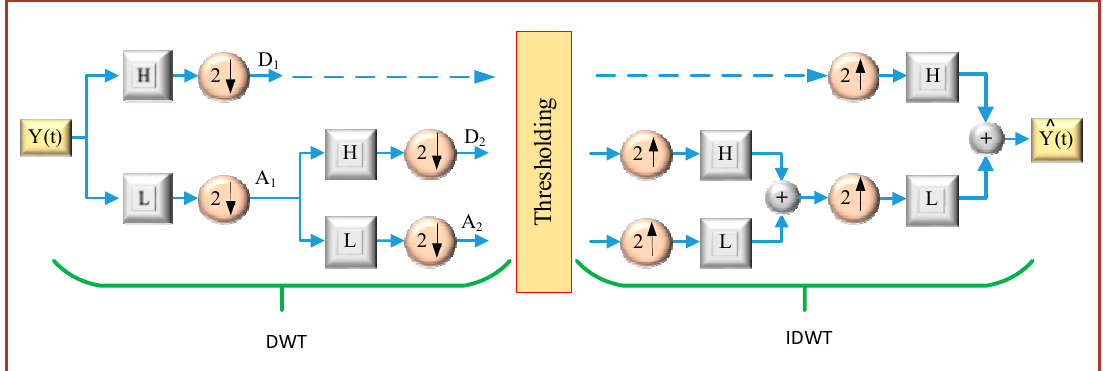
Figure 2. The schematic diagram of the process of denoising by wavelet transform, including decomposition with DWT, thresholding, and inverse DWT.